Question: Identify the chart type used in this figure.
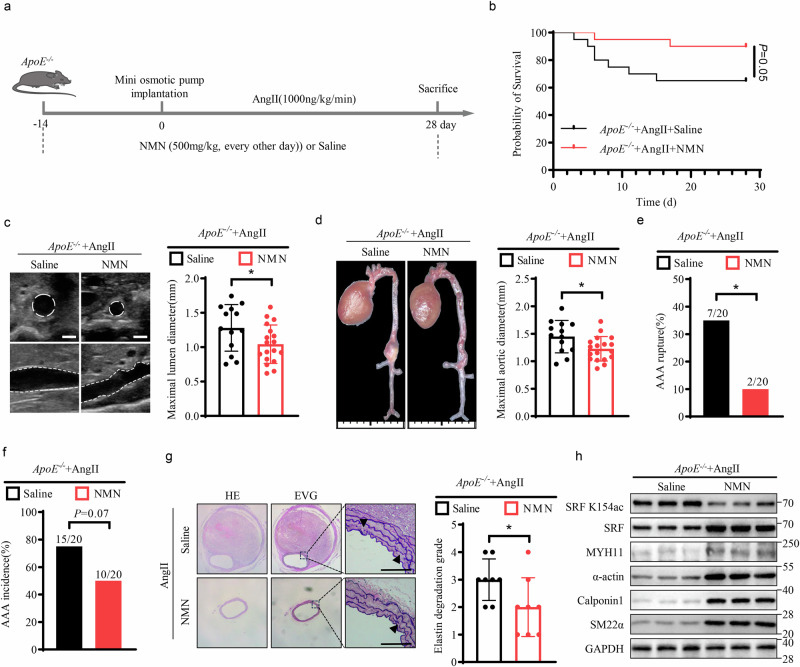
Answer: survival